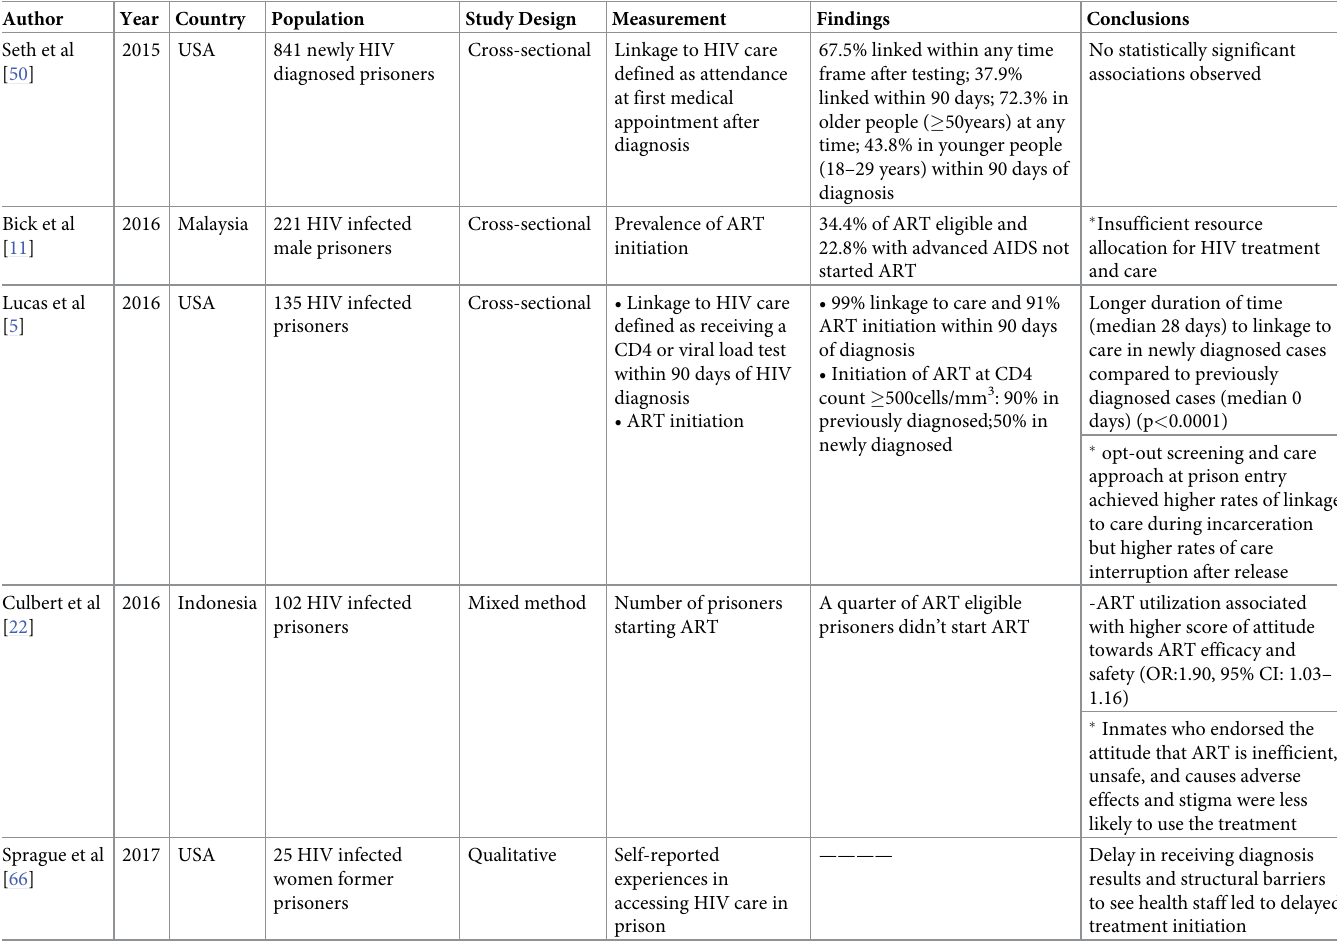
All ART adherence studies measured adherence to dose over varying period of time (days, weeks and months) using different methods (self-report, pharmacy refill, pill count, and elec- tronic monitoring cups). Three studies considered adherence to medication schedule as an alternative measure to dose adherence [25–27]. Table 2 depicts how adherence was defined by the studies. Two studies set optimal adherence at 100% [17, 45] and other two used a threshold of > 95% [15, 20]. Three studies defined non-adherence as missing more than three doses or schedules in a week [25–27]. The cut-off for viral suppression also varied greatly among stud- ies, ranging from < 40copies/mL [56, 69] to < 500copies/mL [17, 21]. Eight studies used < 400copies/mL [4, 19, 58–61, 63, 64] and four used < 200copies/mL [5, 16, 57, 62]. In this review, we dichotomised the outcomes based on the highest cut off values used in the included studies; adherence < 100% as a threshold for non-adherence and viral load < 500 copies/mL for viral suppression. Most studies measured immunological outcomes as a change in CD4 count between two points in time (e.g. between entry and release from prison). Table 3 shows definitions of immunological and virological outcomes used by the